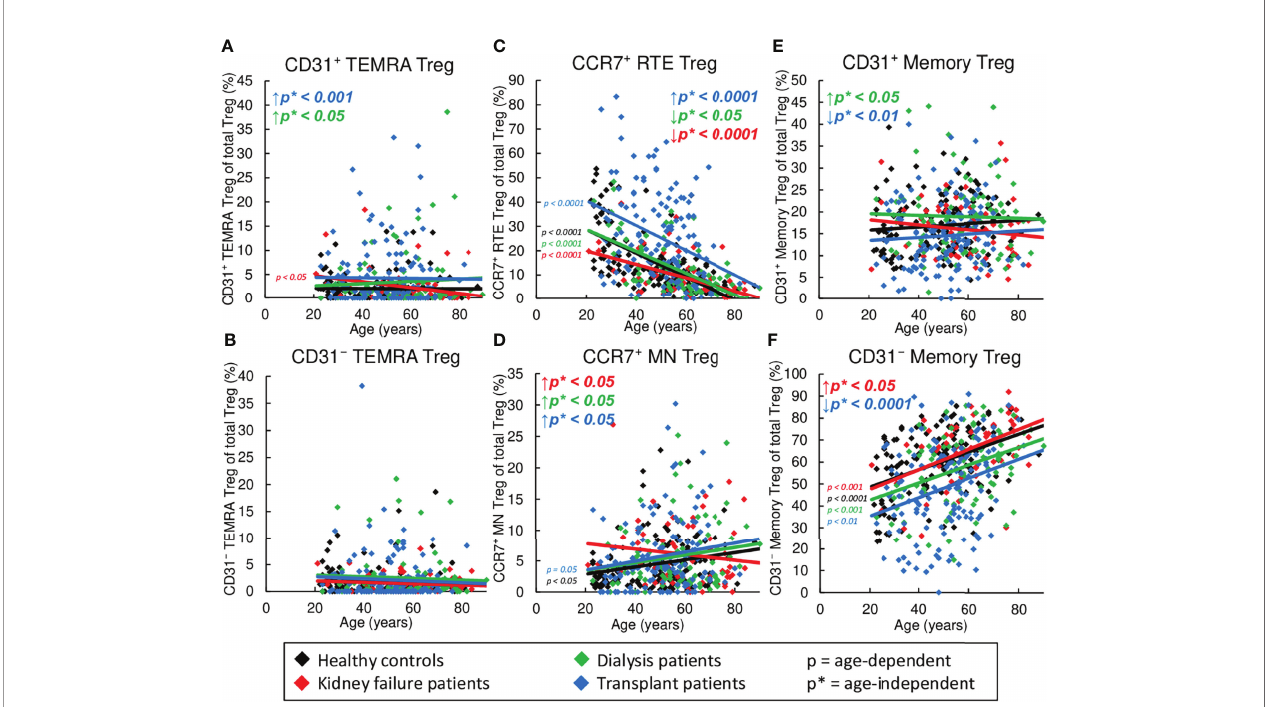
FIGURE 4 | Changes in the composition of CD8 + Tregs with differentially matured subsets in healthy controls (n=134), KF patients (n=57), dialysis patients (n=87), and kidney transplant patients (n=138). The fi gures present the percentages of CD31 + TEMRA (A) , CD31 - TEMRA (B) , CCR7 + RTE (C) , CCR7 + MN (D) , CD31 + memory (E) , and CD31 - memory Tregs (F) within total Tregs of healthy volunteers ( ♦ ), KF patients ( ♦ ), dialysis patients ( ♦ ), and kidney transplant patients ( ♦ ). Regression lines concerning changes in the percentages with age are shown for both healthy volunteers and all patient groups. Signi fi cant changes are marked by color-matched p-values. Age-independent signi fi cant differences between healthy volunteers and study groups are marked by an arrow ( ↑↓ ) and their color-matched